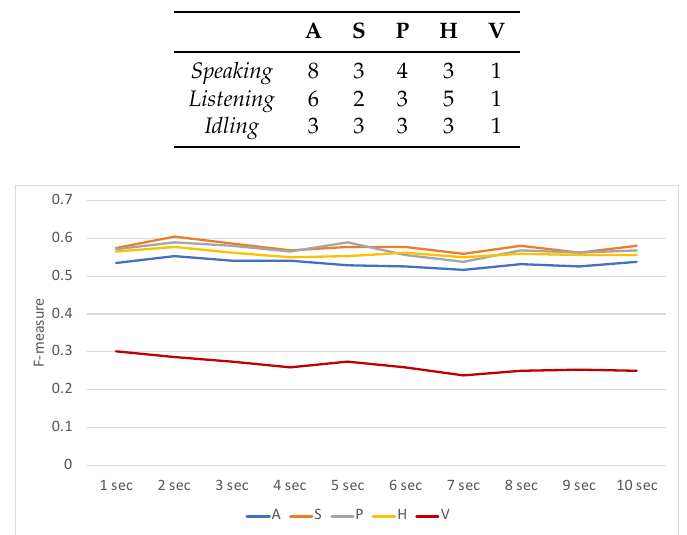
Figure 3. F-measure values (shown as the vertical axis) of each feature set in speaking model according to window size from 1 to 10 s.